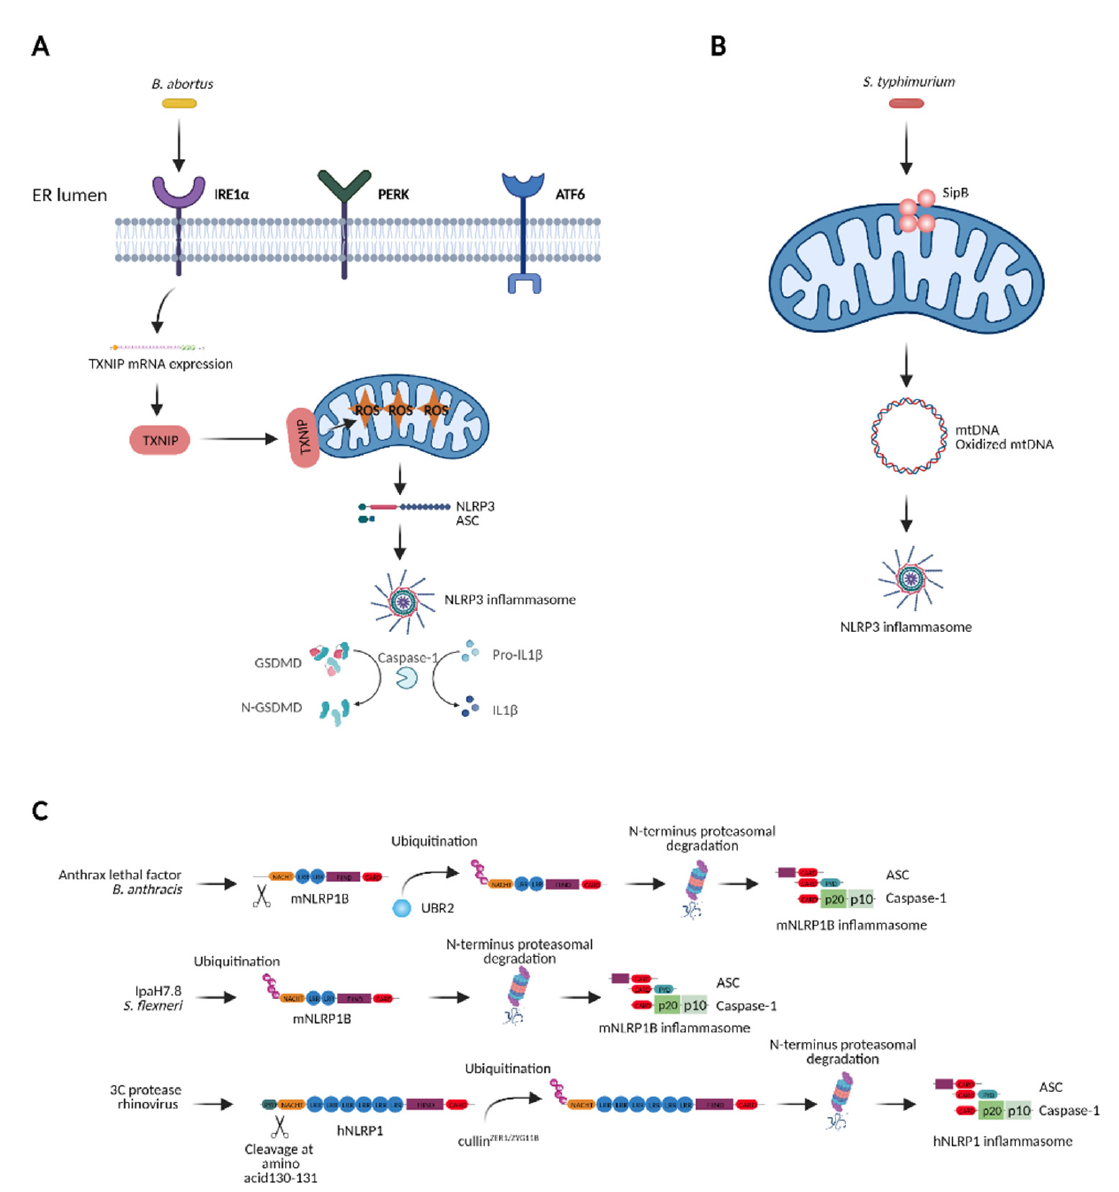
Figure 5. Distinct NLRP inflammasomes are activated by ER stress, mitochondrial dysfunction or directly by pathogens. ( A ) B. abortus induces ER stress, which causes NLRP3 inflammasome activation. ( B ) S. typhimurium targets mitochondria to trigger NLRP3 inflammasome activation. ( C ) Murine and human NLRP1 (mNLRP1B, hNLRP1) are targeted by pathogen virulence factors. Abbreviations: PERK, PKR-like ER kinase; IRE1 α , inositol-requiring enzyme 1 α ; ATF6, activating transcription factor 6; TXNIP, thioredoxin-interacting protein; ASC, apoptosis-associated Speck-like protein containing a CARD; GSDMD, Gasdermin D; UBR2, ubiquitin protein ligase E3 component N-Recognin 2; ROS, reactive oxygen species; mtDNA, mitochondrial DNA; SipB, Salmonella invasion protein B; IpaH7.8, invasion plasmid antigen H7.8. Image created with BioRender.com .